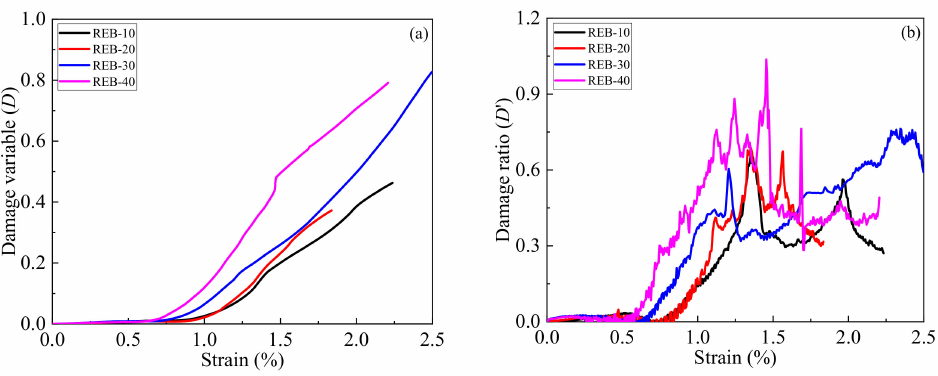
Figure 11. Damage and damage ratio evolution curves: ( a ) damage curve; ( b ) damage ratio